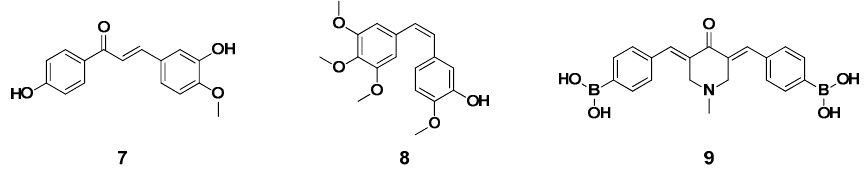
Figure 2. Structures of chalcone ( 7 ), combretastatin ( 8 ), and bis-chalcones ( 9